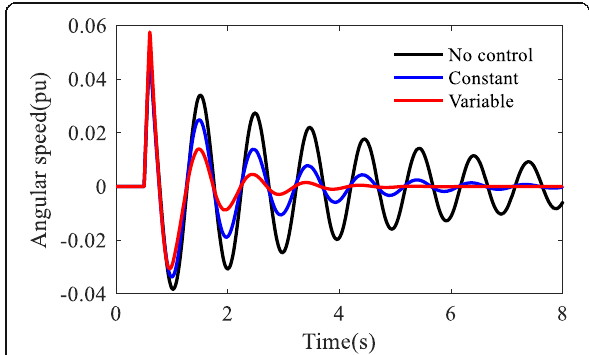
Fig. 9 The angular speed difference between the SG and the PV-VSG when the output power of the PV is 0.9 pu